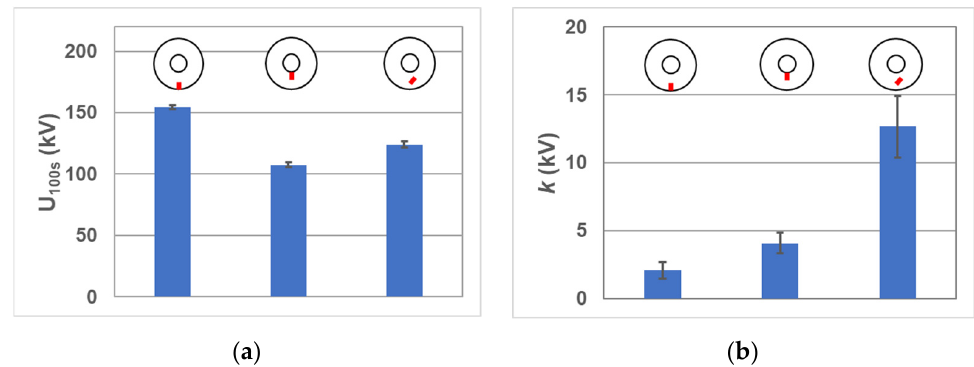
Figure 8. U 100s ( a ) and k ( b ) values for the tests in CO 2 at 0.75 MPa, with the 4 mm particle either free, or attached to the inner electrode or the enclosure in set-up 2.